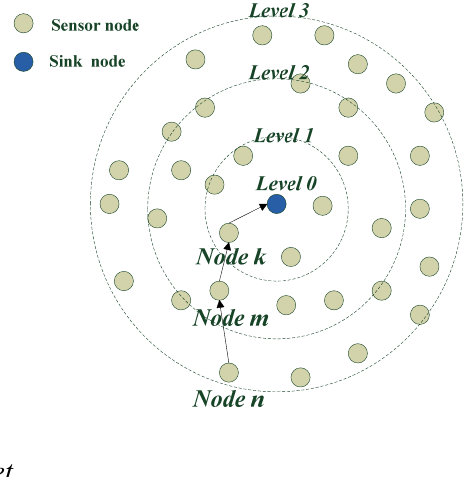
Figure 10. Sensor node sends a reply packet to the sink node in a random